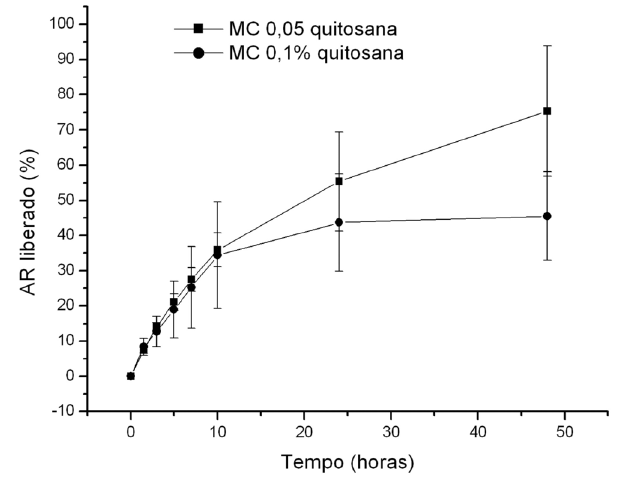
de babaçu incorporadas em gel Natrosol ® .